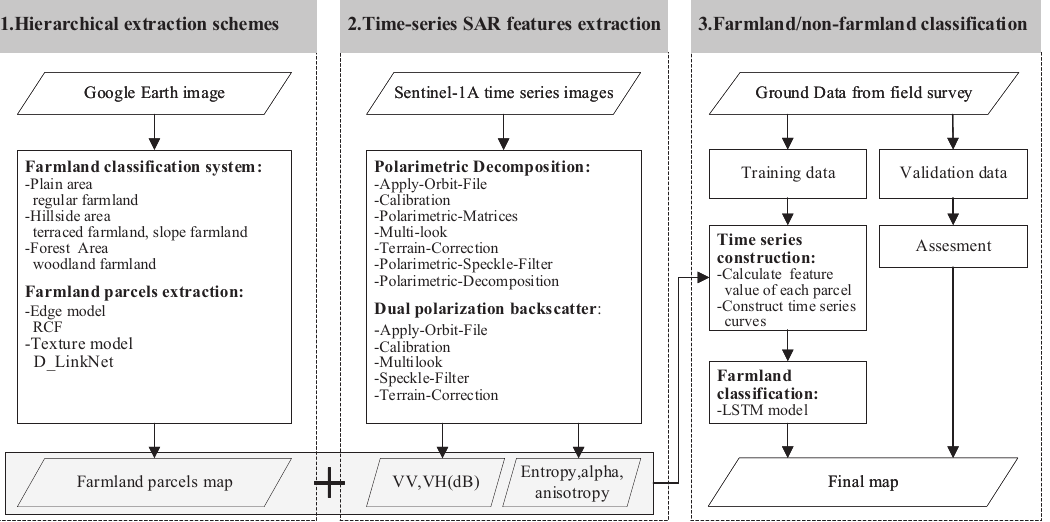
Figure 2. Workflow of the method proposed in this paper.